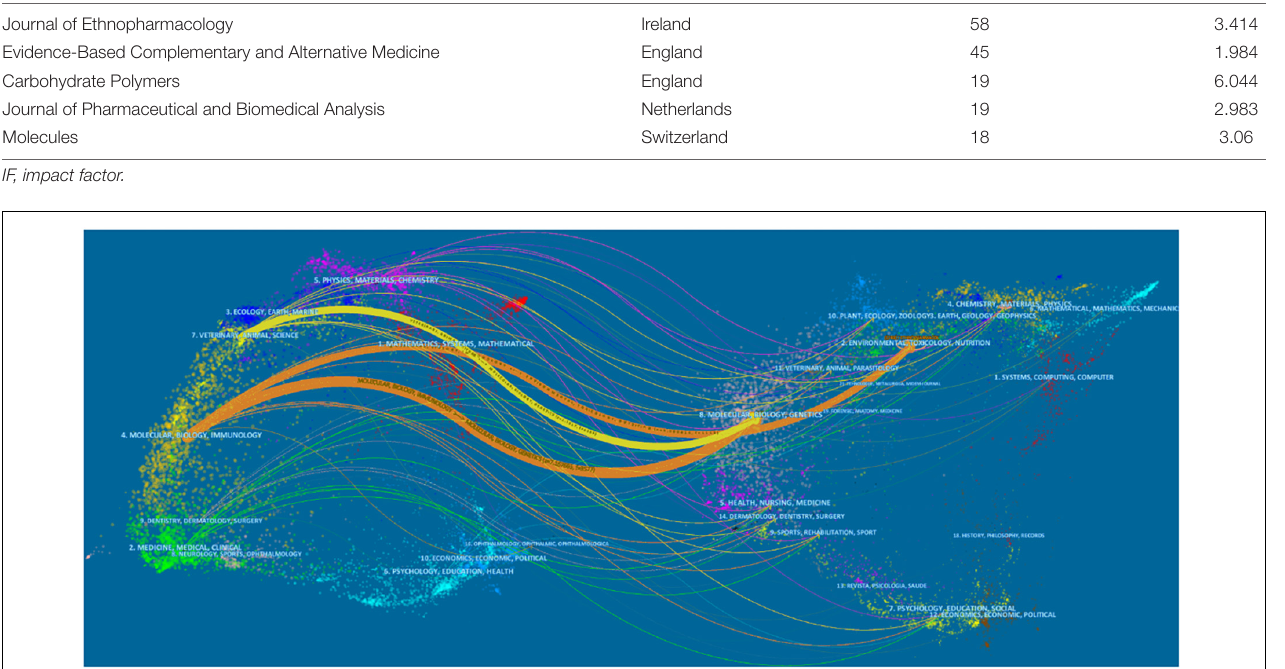
FIGURE 2 | The dual-map overlay of Angelica sinensis